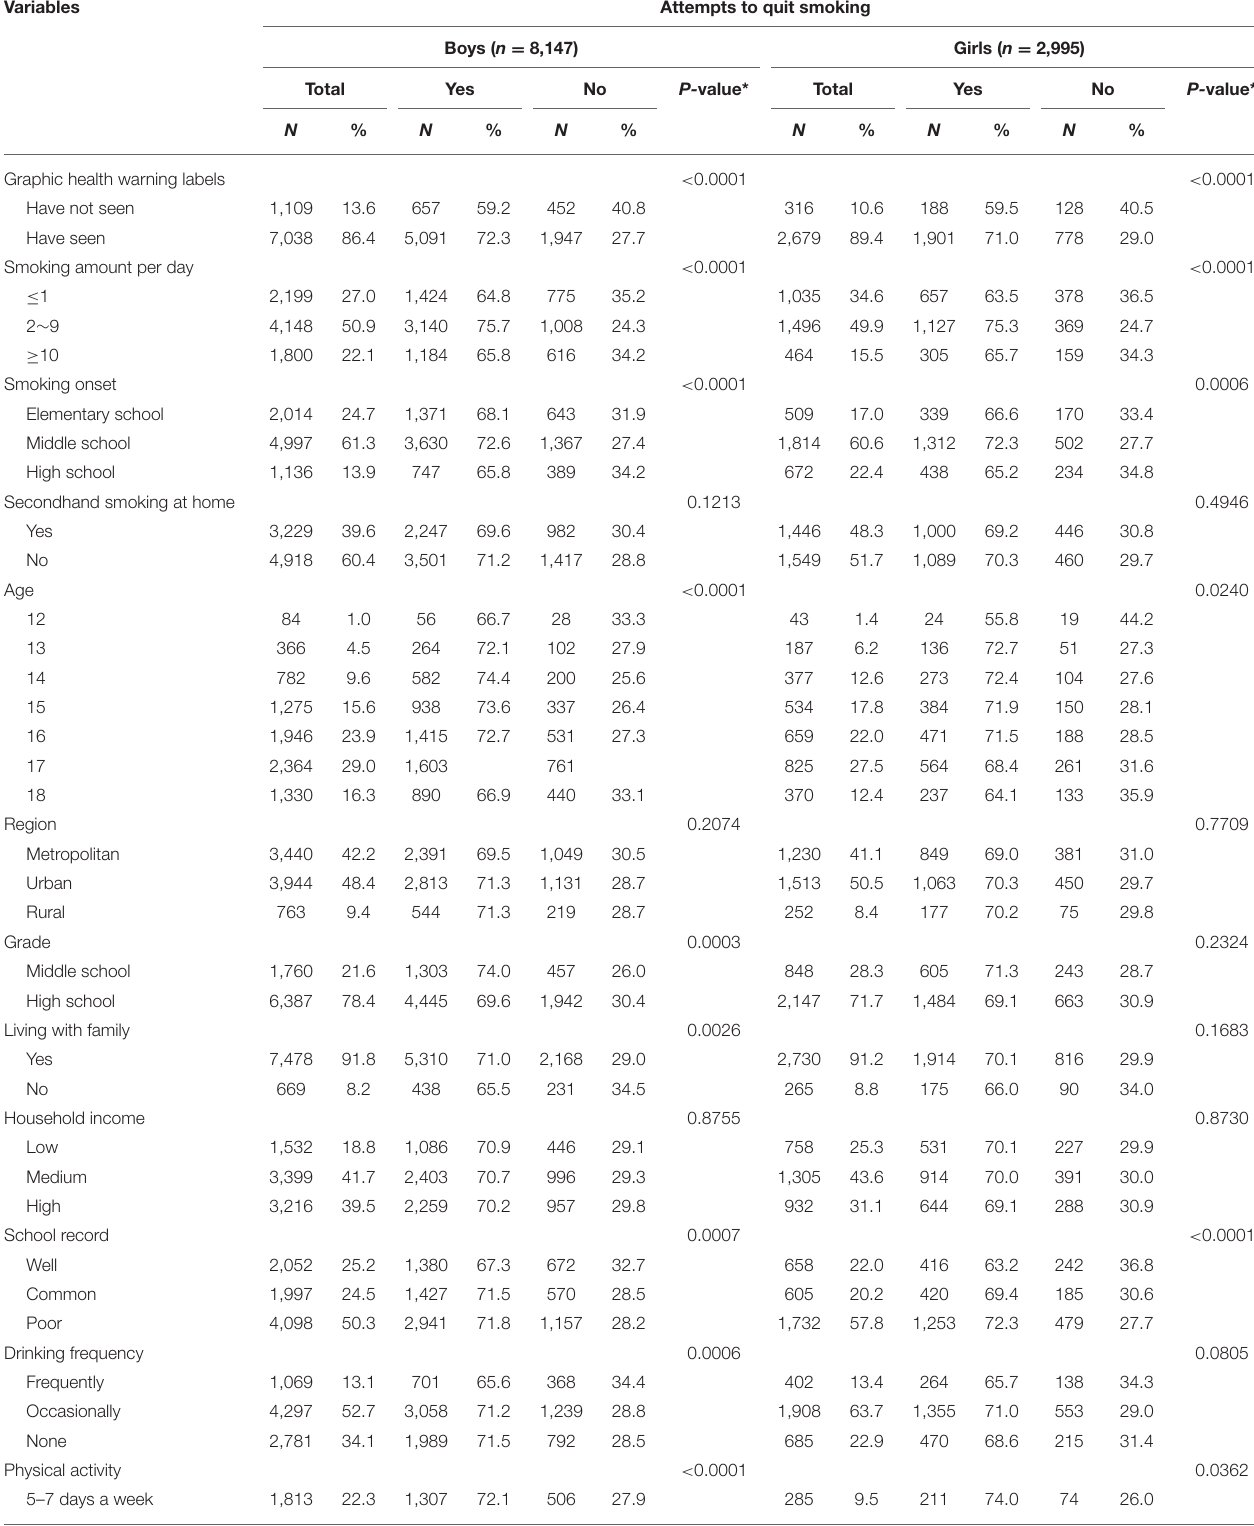
TABLE 1 | General characteristics of the study